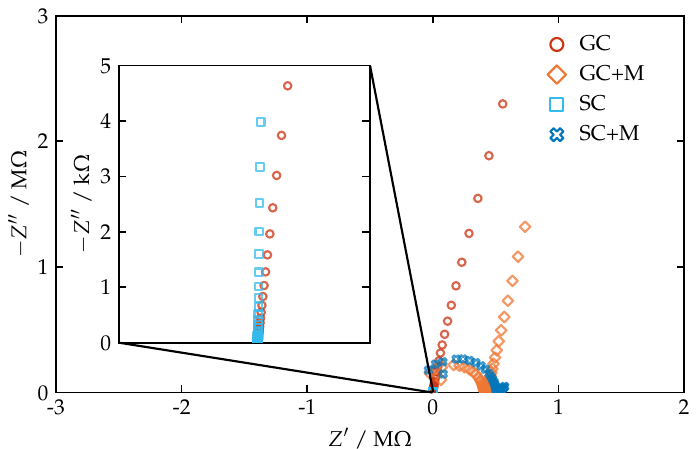
Figure A3. Impedance spectra of the following PCTFE-shelled electrodes: bare glassy carbon (GC), glassy carbon with a membrane (GC+M), glassy carbon with PEDOT:Cl as a solid contact (SC), and glassy carbon with both PEDOT:Cl as a solid contact and a membrane (SC+M). The electrodes with membranes were prepared by drop-casting 40µL of the MC9N1/50 membrane cocktail. The solid contacts were identical to the solid contacts used throughout the rest of this study. The redox capacitances of the PEDOT:Cl layer and the bare glassy carbon were approximately 400µF and 1µF, respectively. See Table 1 for the composition of the MC9N1/50 membrane. Table A4. The membrane bulk resistance ( R b ), geometric capacitance ( C g ), conductivity ( σ ), and dielectric constant ( ε r ) of coated wire electrodes (CWEs) with MC9N1/25 membranes of different thicknesses ( L ). The number of measurements and the number of sensors were n = 1 and k = 3, respectively, unless noted otherwise. Measurements were performed in 10 − 1 M sodium acetate with the parameters f = 100mHz–100kHz, E dc = 0V vs. OCP, and ∆ E ac = 100mV ( RMS ) . See Table 1 for the composition of the MC9N1/25 membrane. L